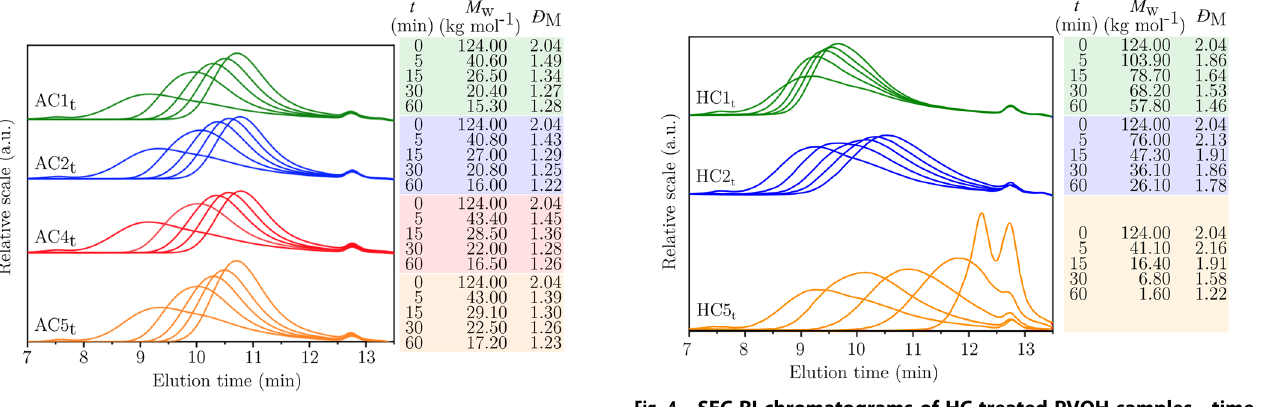
Fig. 3 SEC-RI chromatograms of AC treated PVOH samples - time dependent cavitation treatments. Each colour series shows SEC-RI chromatograms obtained after 0, 5, 15, 30 and 60 min (left to right). Conditions applied: AC1 t (25°C), AC2 t (25°C + H 2 O 2 ), AC4 t (60 °C), AC5 t (60°C + H 2 O 2 ). Right columns show treatment time t, M w and Đ M .